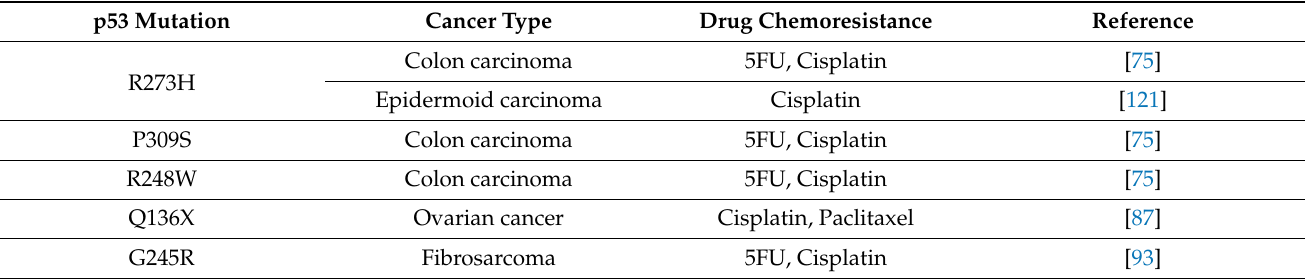
Table 3. Relationship between p53 mutations and